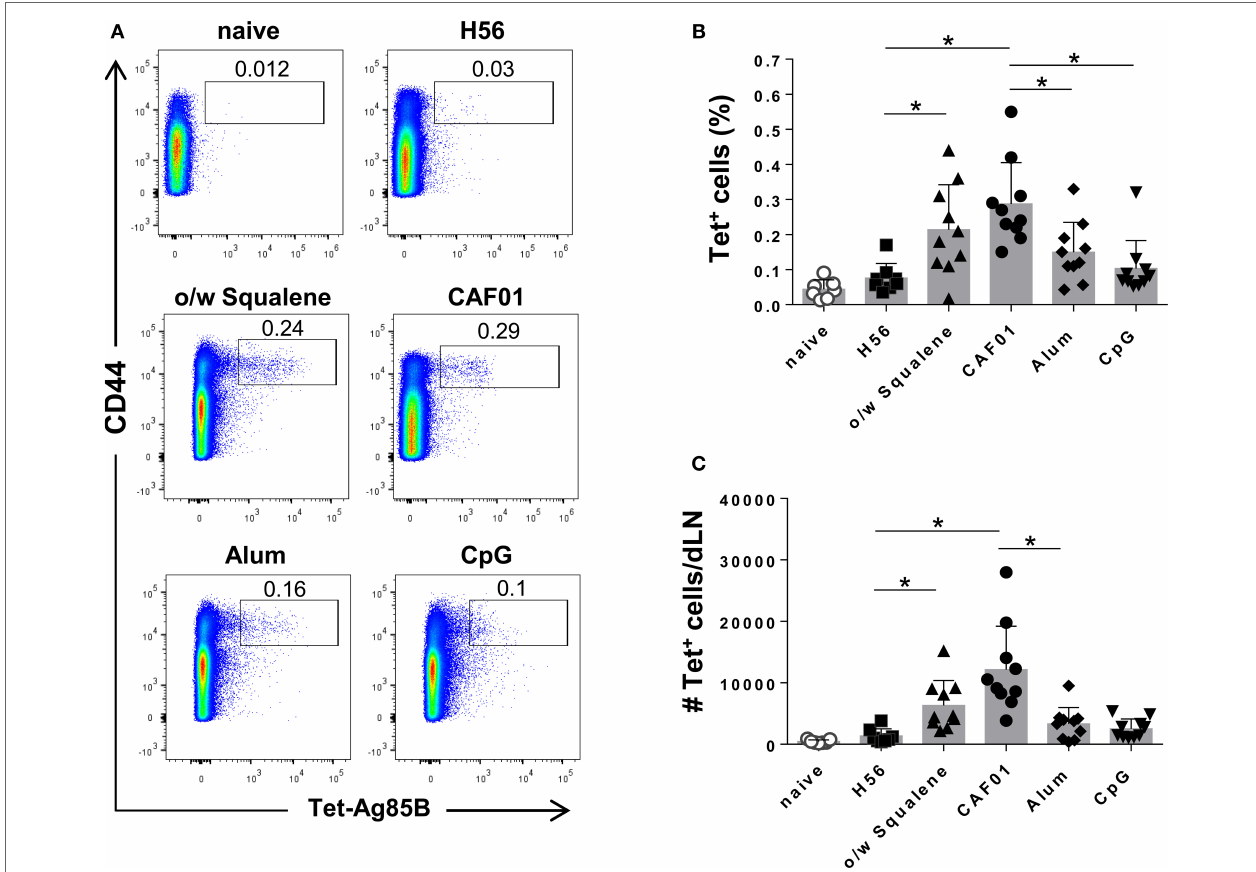
FigUre 1 | induction of ag85B-specific cD4 + T cells . C57BL/6 mice were subcutaneously immunized with H56 alone (H56) or combined with different adjuvants (o/w squalene, CAF01, alum, and CpG), and lymph nodes draining the site of immunization (dLN) were collected 7 days after immunization. Ag-specific T cells were identified by staining with Ag85B-specific MHC class II tetramers (Tet-Ag85B). (a) Tetramer + T cells, detected as CD44 high Tet-Ag85B + cells, gated on live CD4 + lymphocytes, are shown from a single animal representative of the group. (B,c) Frequencies of Tetramer + CD44 + T cells, with respect to CD4 + cells (B) and absolute numbers of Tetramer + CD44 + T cells per dLN (c) elicited by different vaccine formulations, reported as mean ± SD of 8–10 mice per group, from 2 independent experiments. Mann–Whitney test with Bonferroni correction for multiple pairwise comparisons was used for assessing statistical difference between each group immunized with adjuvant and the H56-immunized group. Kruskal–Wallis test, followed by Dunn’s post test for multiple comparisons, was used to assess the statistical difference between groups immunized with different adjuvants (* P ≤